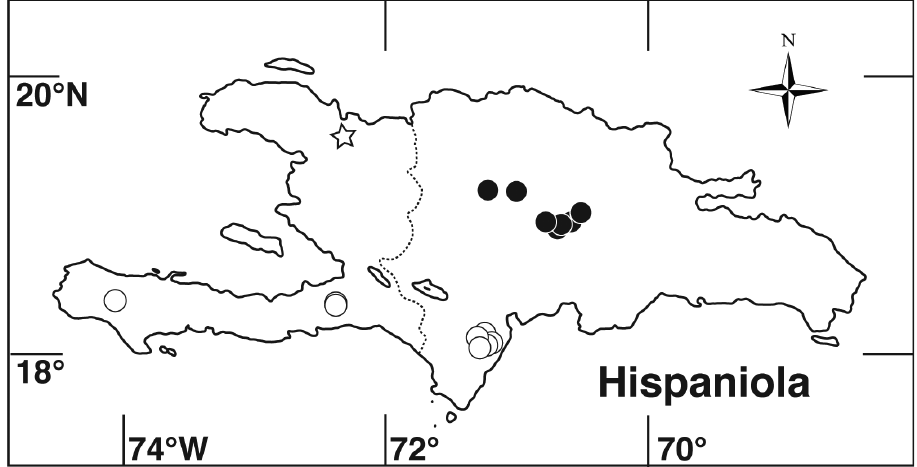
Figure 23. Distribution of Miconia phyrnosomaderma (open star), M. limoides (open circles), and M. paralimoides (closed